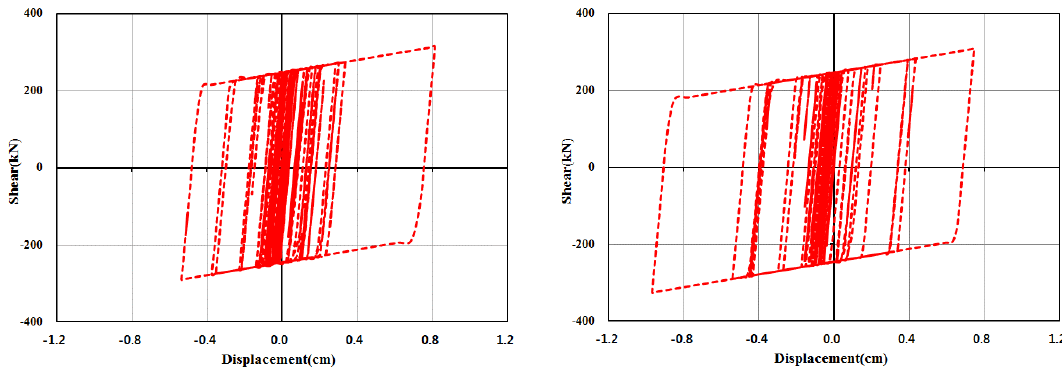
Figure 27. Hysteretic curves of the WKDS (El-Centro EW, 1F).